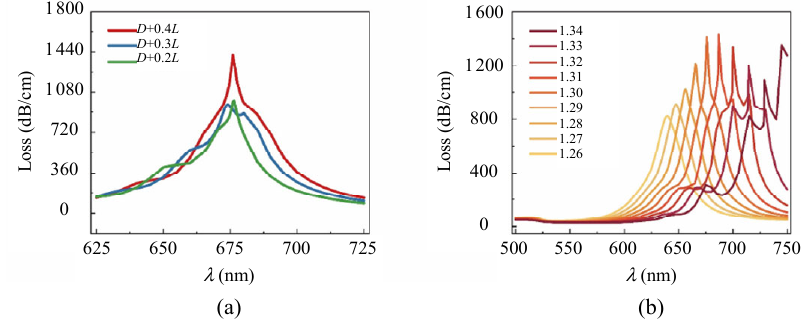
Fig . 5 Extra information for geometric parameter impacts: (a) loss spectra for the hole size larger than D+ 0.1 L at n a = 1.30 and (b) loss spectra for D+ 0.4 L with different n a